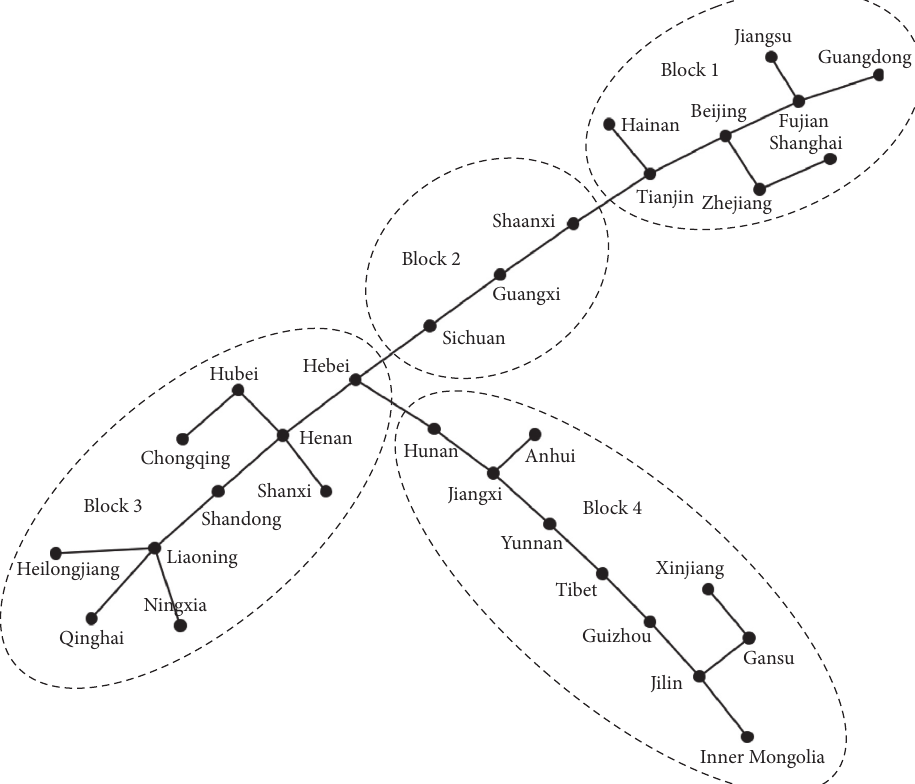
Figure 4: Network structure of digital financial inclusion development in China from 2011 to 2018 based on the MST approach. Table 5: QAP correlation analysis of spatial association matrix R and its influencing factor matrices.